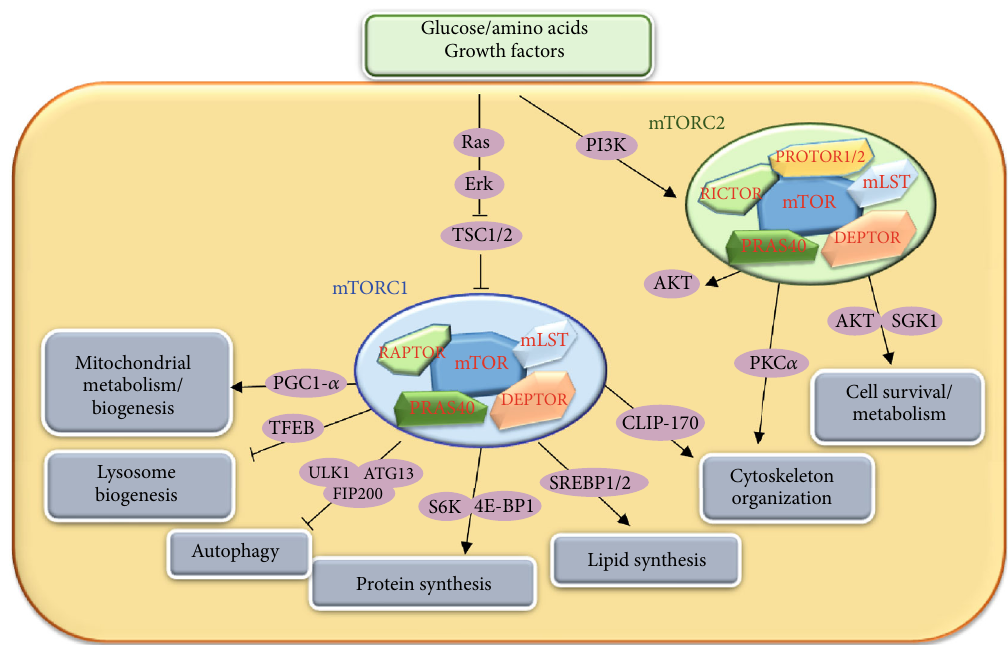
Figure 1: mTOR signaling pathway and its functions. After receiving the extracellular signals, including glucose, amino acids, or growth factor, a series of signaling molecules (Ras, PI3K, AKT, and so on) upstream of mTORC1 are activated; then, mTORC1 and its downstream molecules are activated to regulate a series of cellular processes, such as protein synthesis, autophagy, and mitochondrial metabolism. How mTORC2 is regulated has not been thoroughly studied. mTORC2 mainly regulates cell survival, metabolism, and cytoskeleton organization through SGK1 and PKC α , respectively. mTORC1 and mTORC2 are linked through